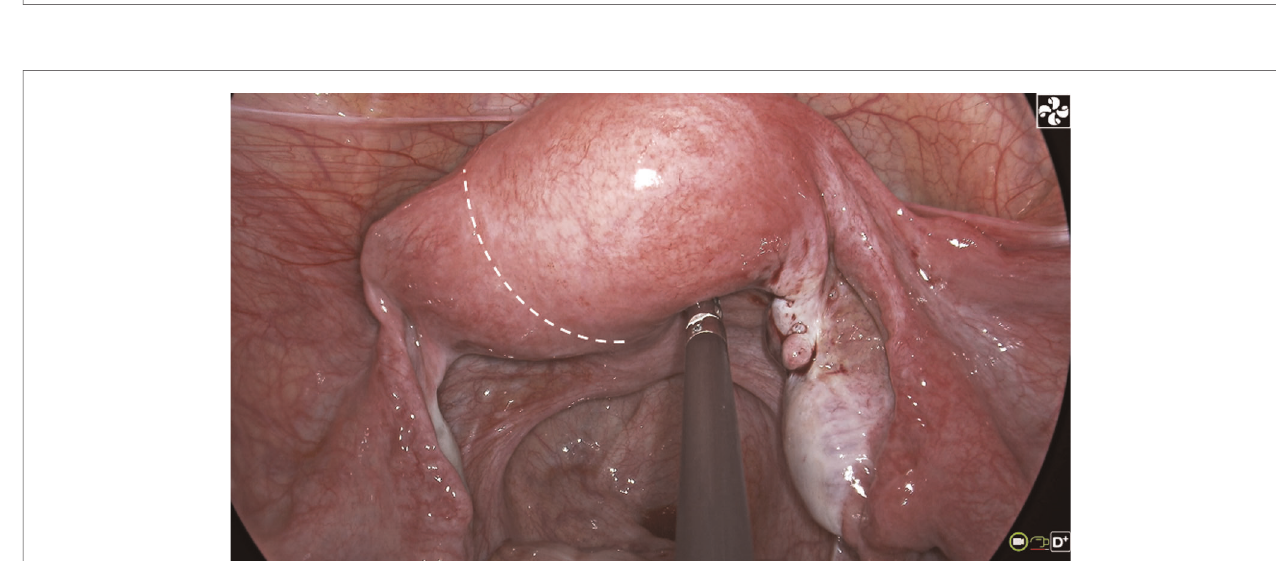
FIGURE 2 | Appearance of uterus during LESS